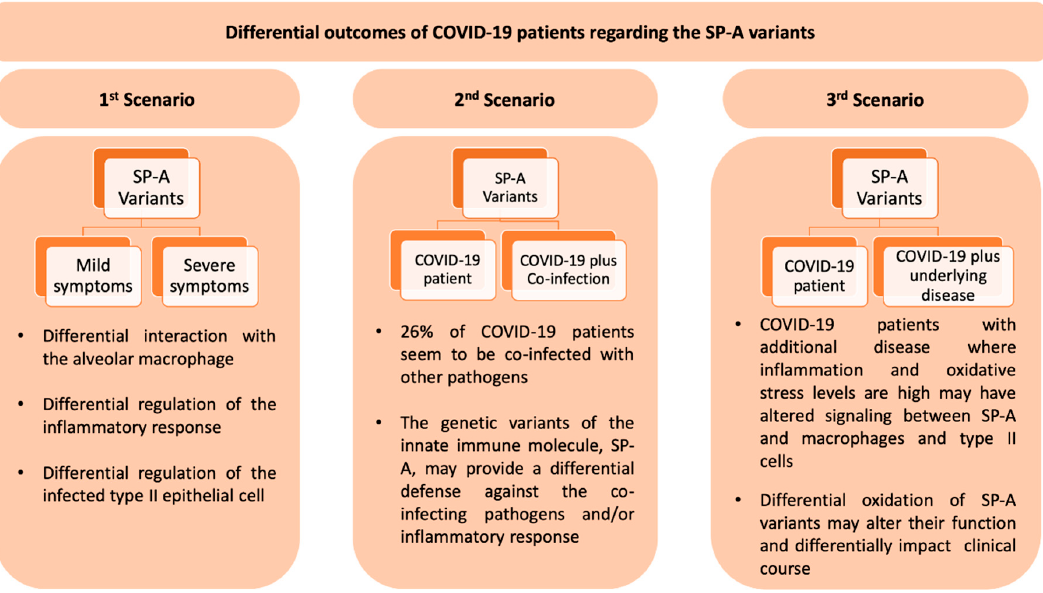
Figure 6. This Figure depicts three scenarios of the potential role of the SP-A innate immune molecules on COVID-19 patients, described in a recent editorial [149] and in part discussed in this review. In the first scenario, individuals with COVID-19 and no co-infection or other underlying disease may experience a differential disease expression from mild to severe based on the SP-A1/SP-A2 genotype. In the second scenario with a co-infecting pathogen, the SP-A genotype may provide a differential host defense against the co-pathogen and an overall differential outcome on COVID-19 patients. In the third scenario patients with underlying disease may experience alterations/dysregulation in inflammatory processes and oxidant levels in the lung. These changes in the lung microenvironment may differentially affect SP-A variant oxidation and thus lung function. In this case the clinical outcome in COVID-19 may vary in ways difficult to predict.